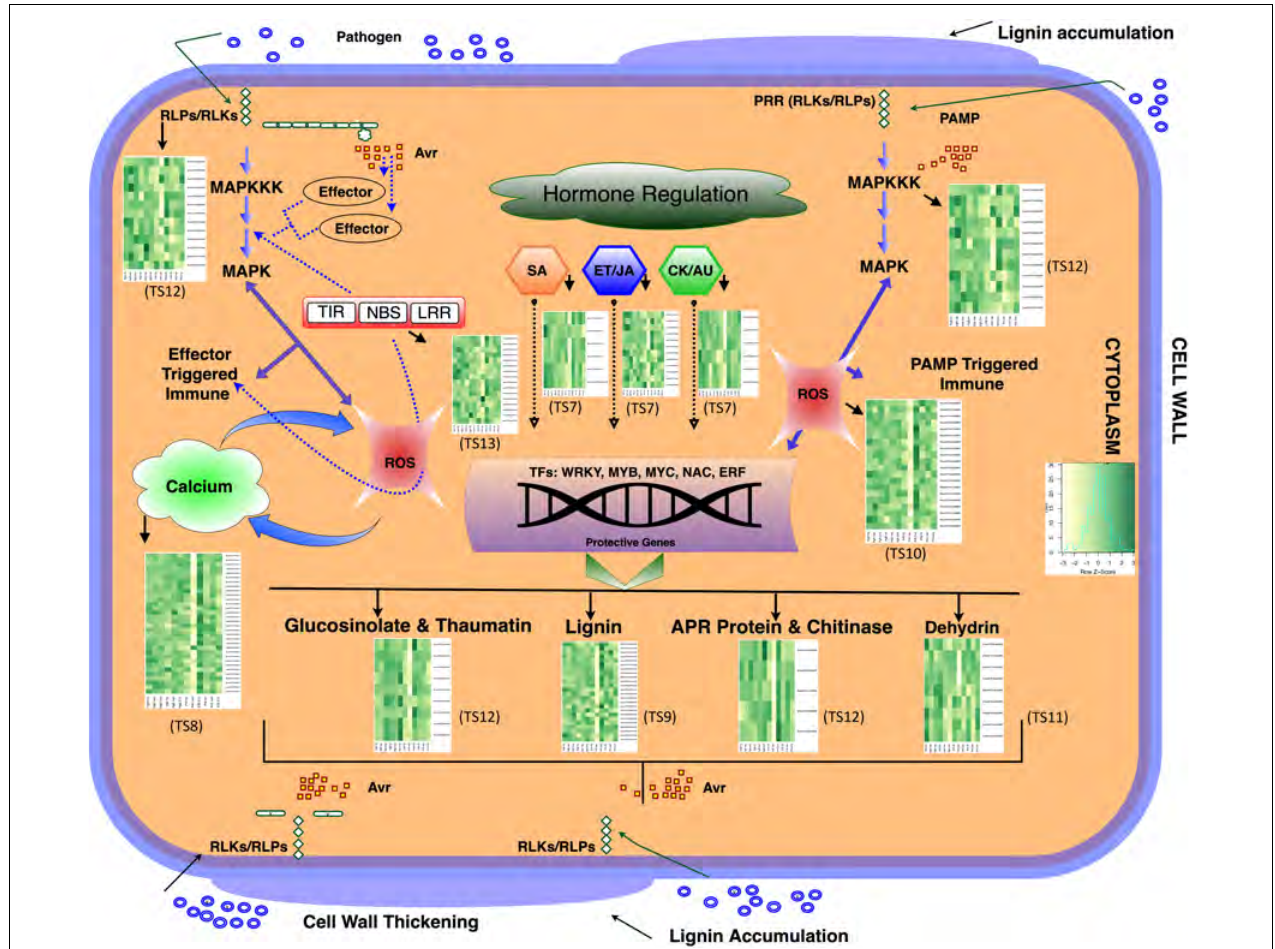
FIGURE 7 | Schematic diagram of plant-pathogen interaction upon P. brassicae inoculation in B. napus . Heatmaps were developed using log 2 fold change values at 7-, 14-, and 21-DPI and were shown besides each major metabolic processes in the plant-pathogen interaction pathway indicated by a dark solid arrow. Dark Green indicates increase in abundance and light color indicates decrease in abundance. Predicted proteins that were included in the heatmaps were significantly ( q < 0.05) differentially abundant at least in one time point across all genotypes investigated. During P. brassicae infection, pathogen releases signal metabolites such as PAMPs and effectors and these elicitors were recognized by host cells. Plant receptors such as receptor like -kinases and -proteins (RLKs/RLPs) and resistance (R) proteins interact with the pathogen signal compounds, thereby activates the MAP kinases (signal transduction). Transcription factors are regulated and successively plant defense related metabolic pathways are activated, proteins related to phytohormone biosynthesis pathway, especially SA, JA, and ET biosynthetic pathway and other secondary metabolism were activated. Pathogen defense related secondary metabolites such as glucosinolates, small molecules thaumatin, polyssacharides (lignin), glycosyl hydrolases (chitinases), and a spectrum of antimicrobial and defense related proteins including dehydrin proteins were differentially accumulated in response to the pathogen. Growth regulators, auxin (AU) and cytokinin (CK) were manipulated by the pathogen, the hormones are regulated abnormally, thereby leading to the hypertrophy in the root tissues. There is an interplay between ROS and calcium signaling compounds during plant and pathogen ( P. brassicae ) interaction. Calcium acts as a second messenger and with the involvement of Ca 2 + -pumps, -buffers, and –exchangers, they orchestrates and regulates cellular processes and participates in an interplay with other signaling transduction processes such as ROS. Detail annotation of protein ids shown in the heatmaps are provided in the supplementary tables: TS7 – TS13 ( Supplementary Tables 7–13 ). Avr, avirulence factor; RLP, receptor like proteins; RLK, receptor like kinase; SA, salicylic acid; JA, jasmonic acid; ET, ethylene; CY, cytokinin; AU, auxin; PRR, pathogen recognition receptor; PAMP, pathogen associated molecular pattern; MAPK, mitogen-activated protein kinase; TIR, toll/interleukin-1 receptor; NBS, nucleotide binding site; LRR, leucine rich repeat; APR, adult plant resistance. PgR-7d, CR progeny 7 DPI; PgR-14d, CR progeny 14 DPI; PgR-21d, CR progeny 21 DPI; PgS, CS progeny; PrR, CR parent; PrS, CS parent.